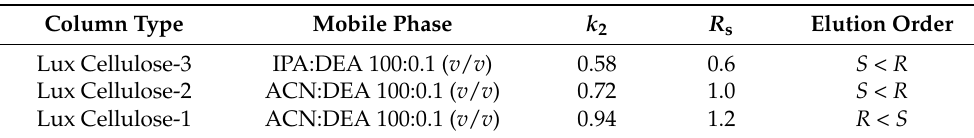
Table 1. Chromatographic data obtained during the preliminary study related to retention factor of the second-eluting enantiomer ( k 2 ), resolution ( R s ), and elution order for the chromatographic systems where enantiorecognition was observed.